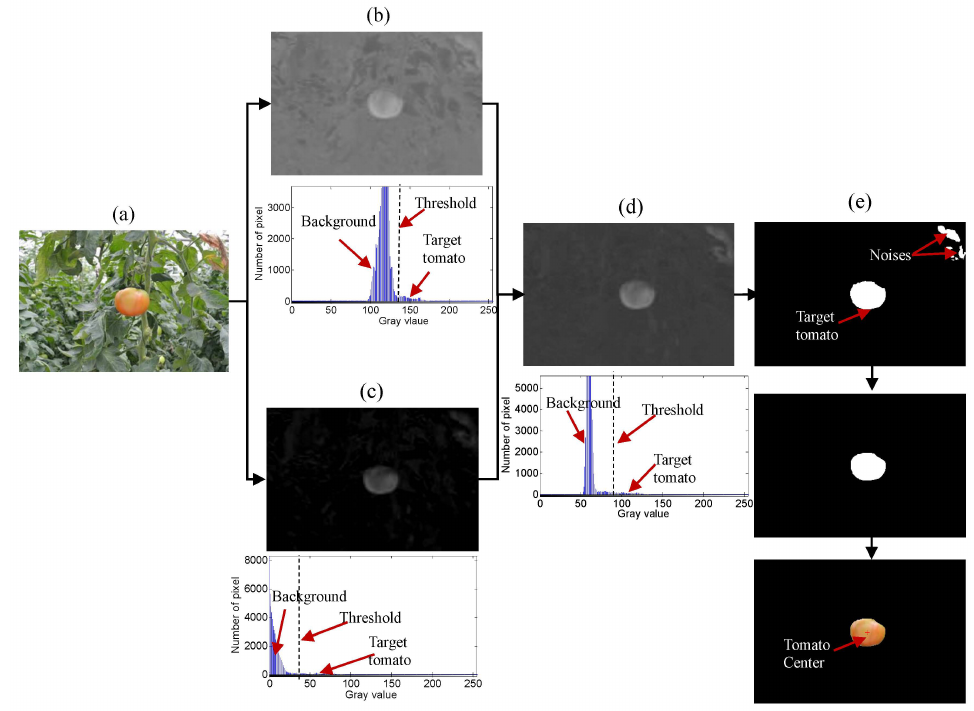
Figure 4. Example of histogram analysis by image fusion. ( a ) Original RGB image; ( b ) a*-component image and its histogram; ( c ) I-component image and its histogram; ( d ) Fusion image and its histogram; ( e ) Result of tomato